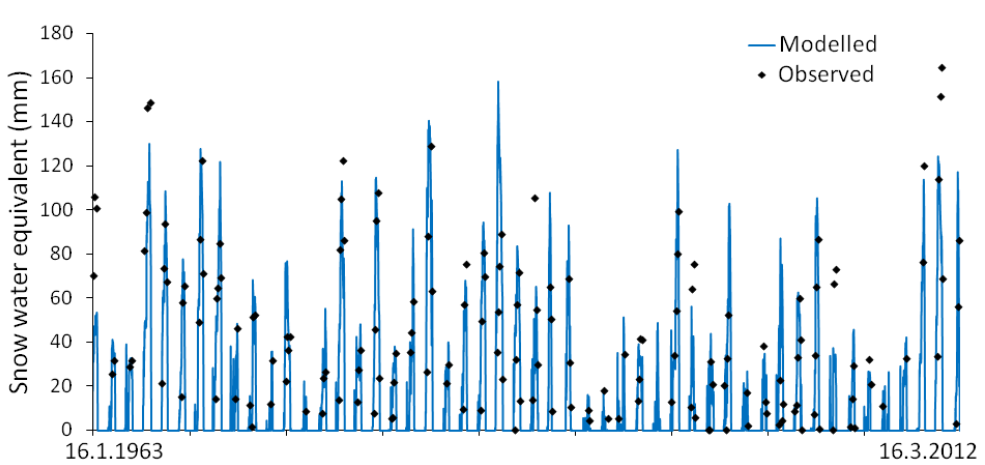
Figure 4. Observed and modelled snow water equivalent values for Hanko,